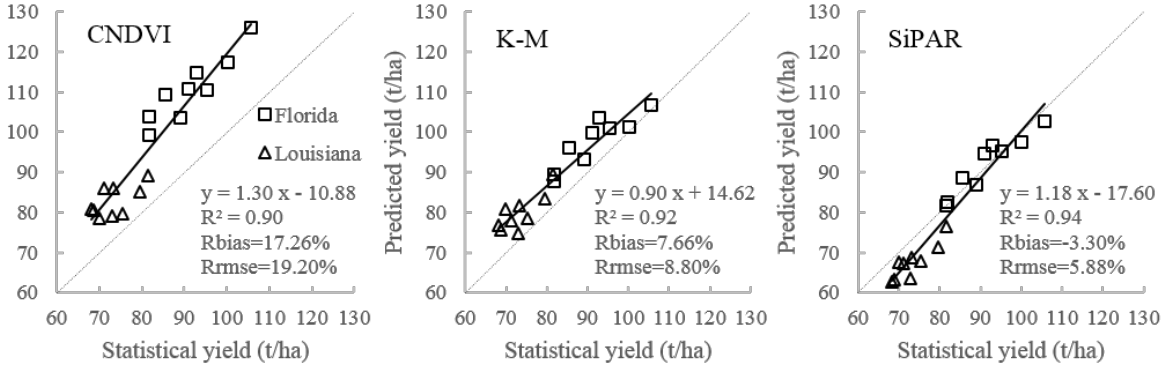
Table 1. The prediction performance under varied planting areas of county. F represents Florida, and L represents